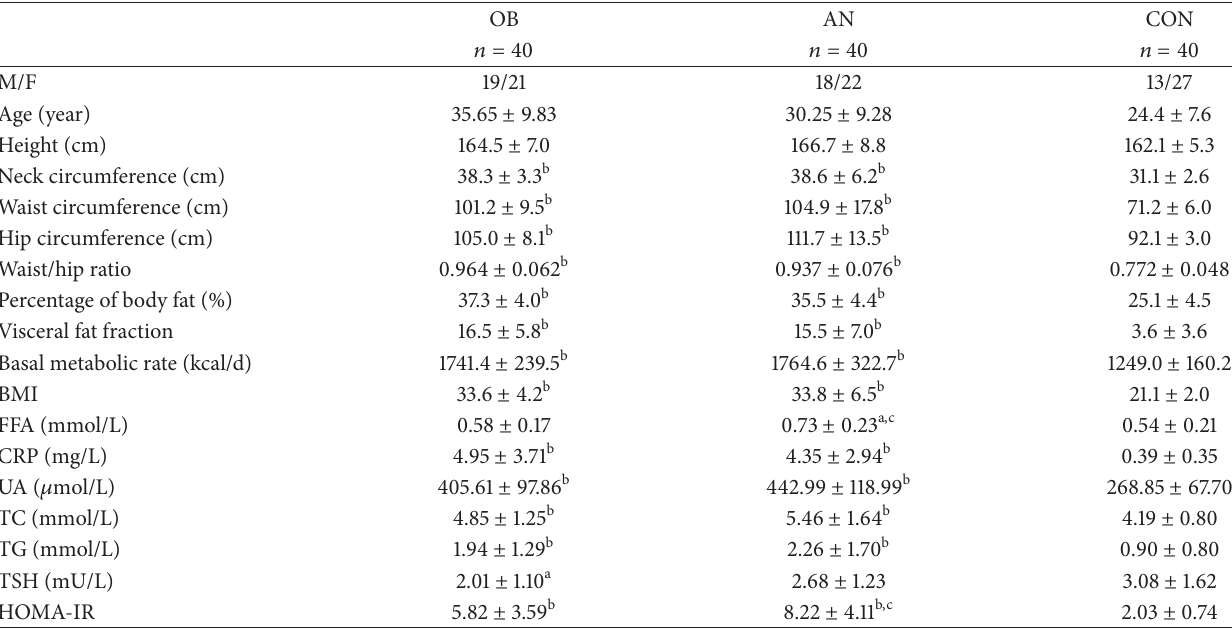
Table 1: Patients’ characteristics and blood test results ( 𝑛 = 120 ).